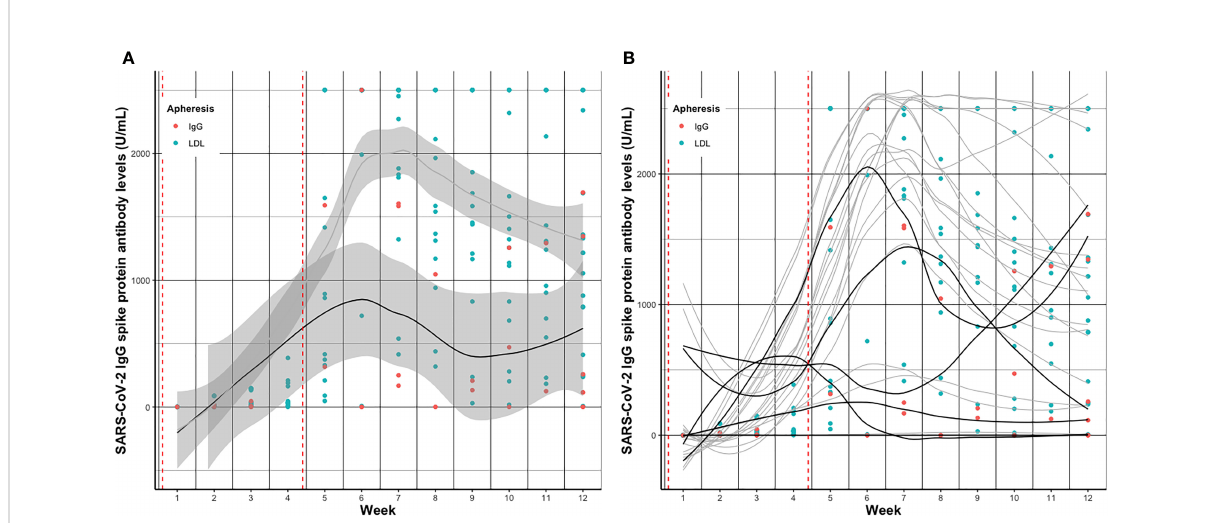
FIGURE 3 Smoothed curves (lines) of (A) average and (B) individual SARS-CoV-2 IgG spike protein antibody levels before apheresis treatment per week after vaccination in patients receiving IgG apheresis (black) and LDL apheresis (grey). Dots indicate individual exact SARS-CoV-2 IgG spike protein antibody levels (red, IgG; blue, LDL) per week. Red dashed vertical lines indicate the fi rst and second vaccination, respectively. In Figure 3B geom_smooth function was used to draw smoothed curves. In case of missing measurements at time points values were extrapolated using the na.approx function of R. Dots indicate exclusively measured